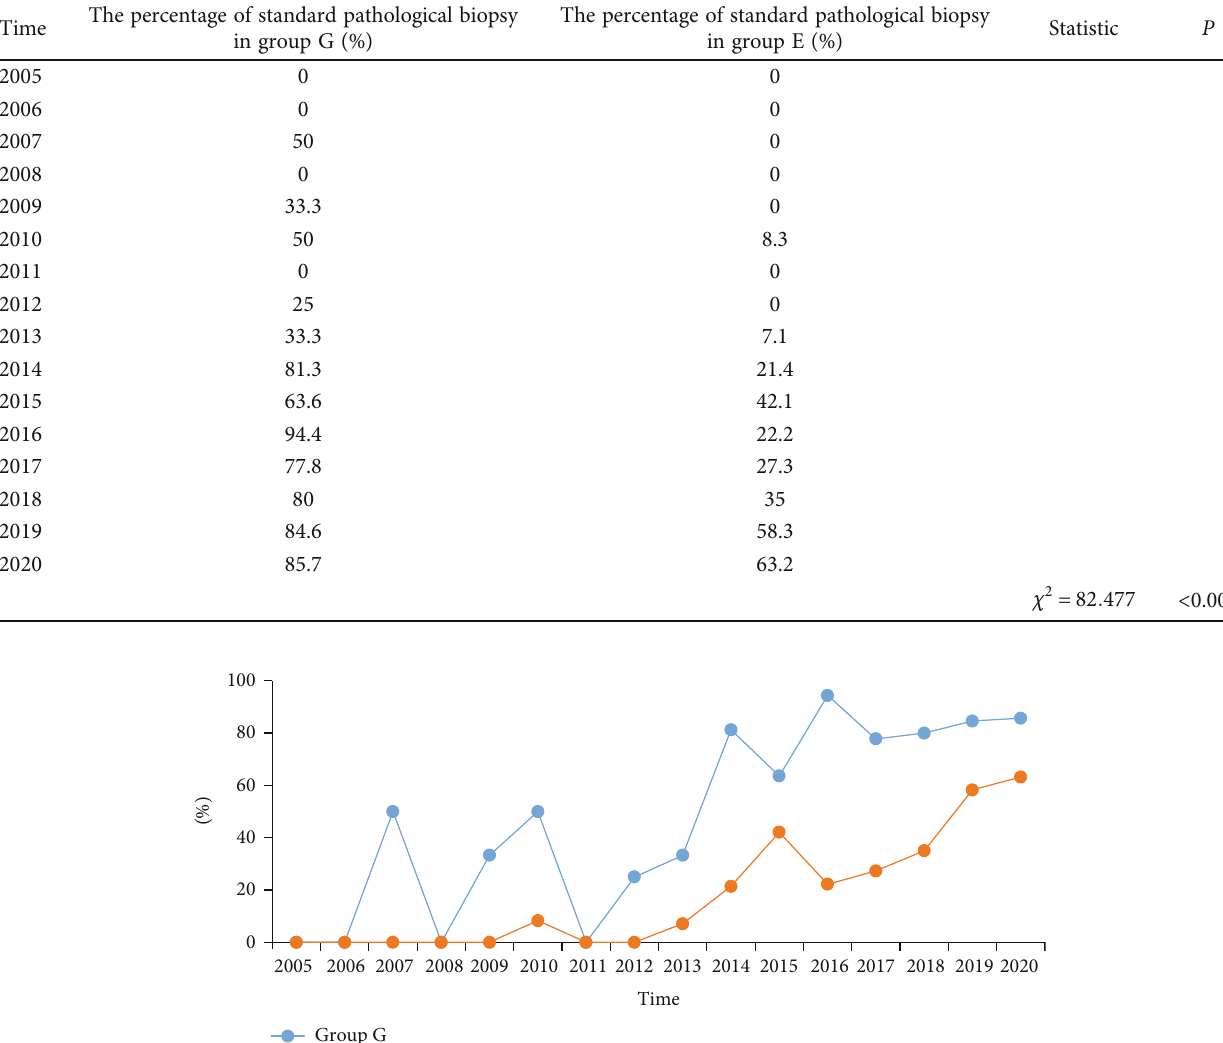
Table 3: Comparison of standard pathological biology between group G and group E. The percentage of standard pathological biopsy The percentage of standard pathological Time in group G (%)